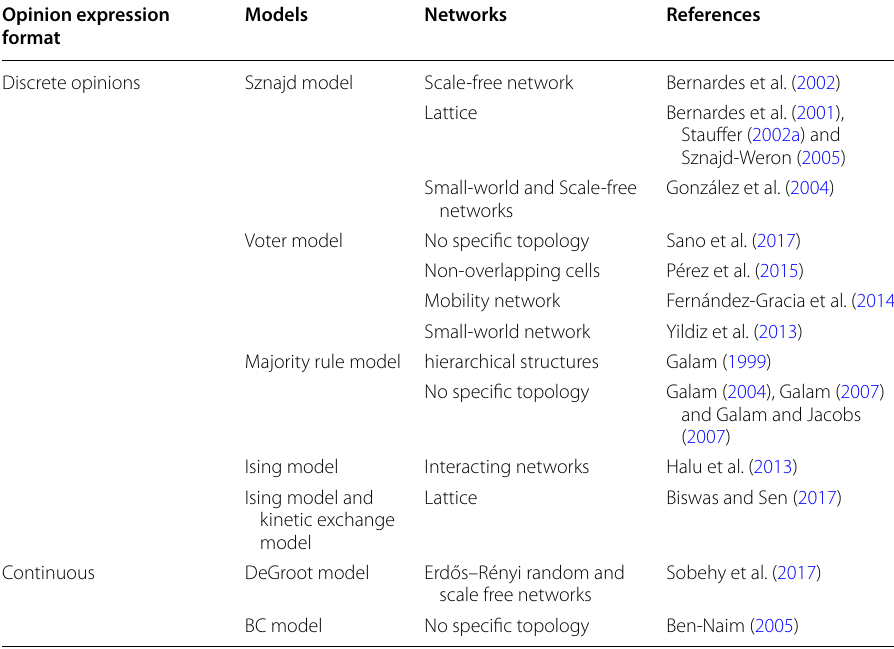
Table 4 The application of opinion dynamics models in politics Opinion expression